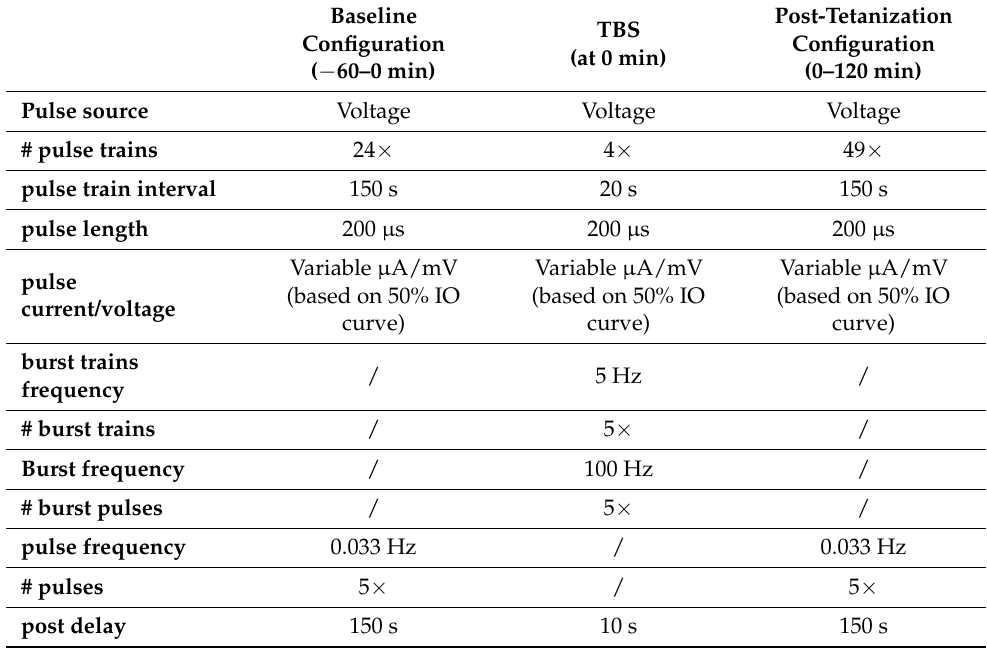
Table 2. The theta burst stimulation (TBS) protocol for induction of LTP in the SC-CA1 synapse: the protocol is composed of long train of 5 bursts of stimulations with 4 pulses at 100 Hz, repeated 5 times, with a pulse train interval of 200 µ